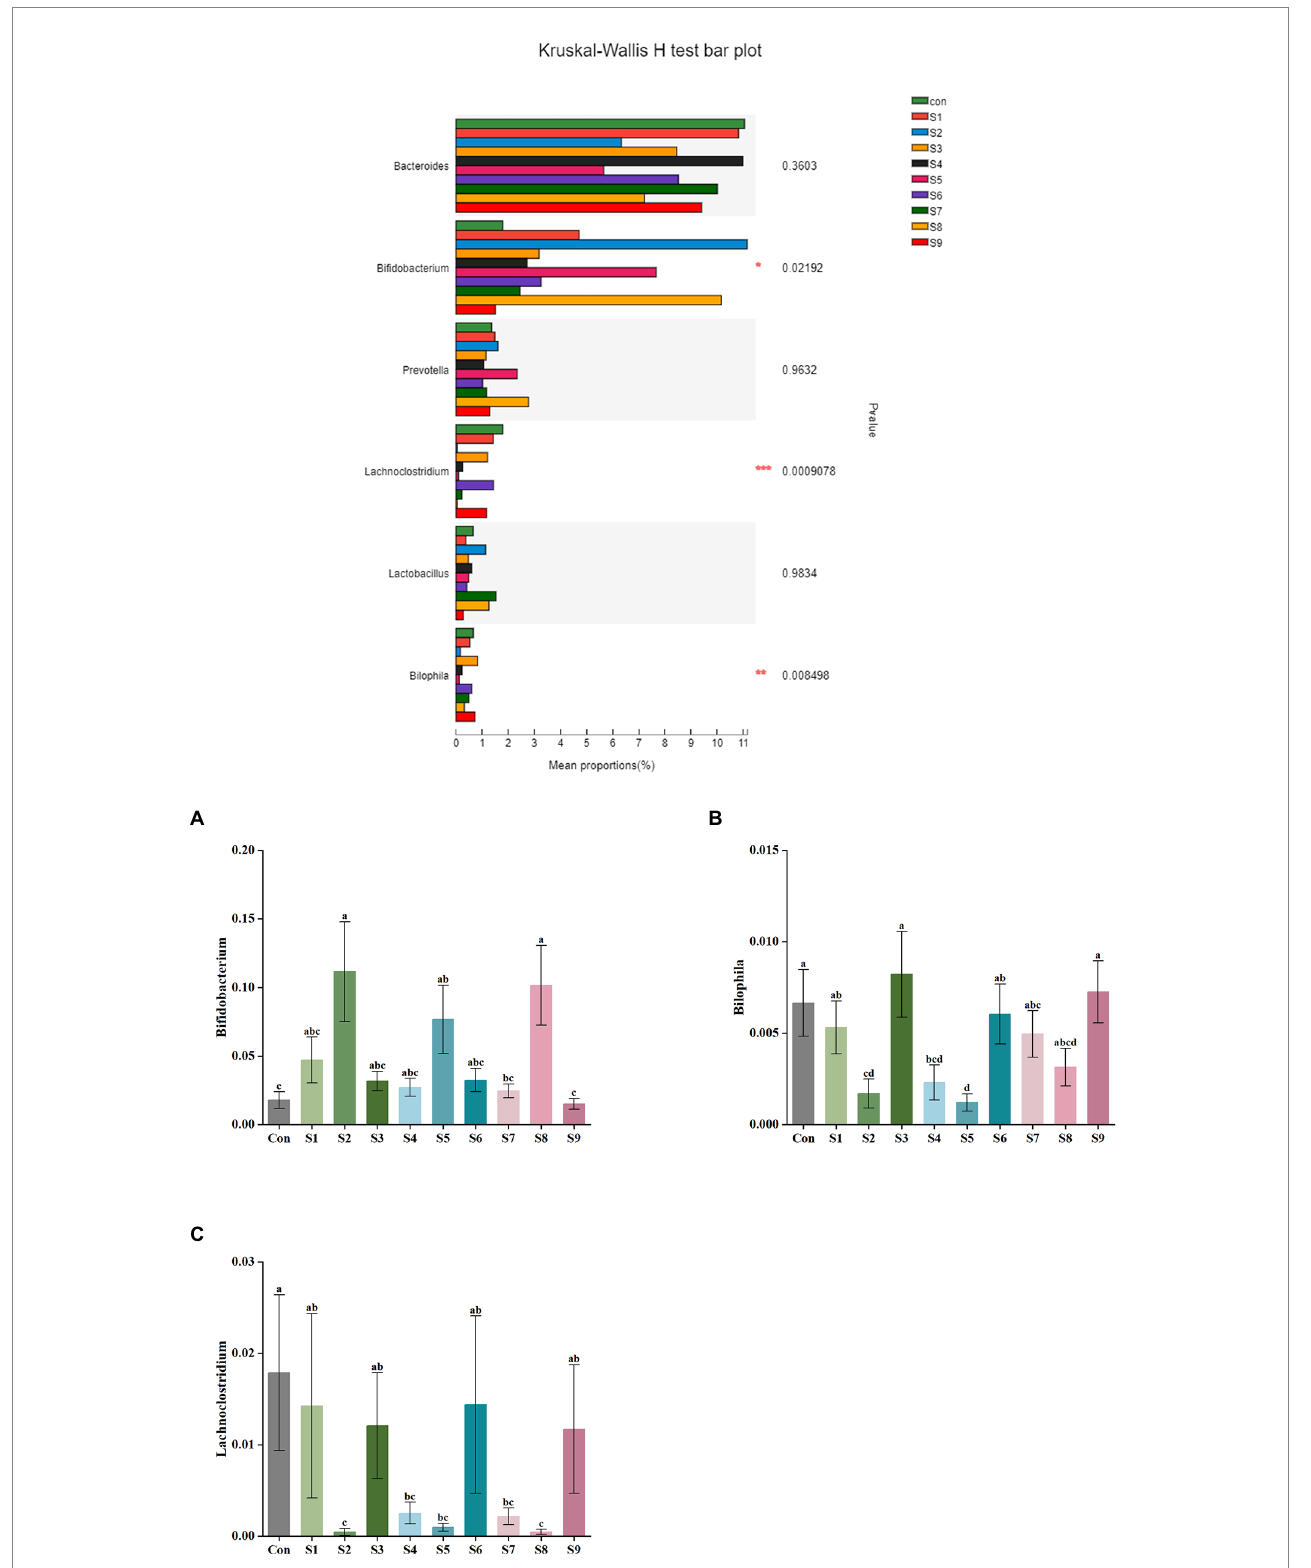
FIGURE 5 Comparison of fecal microbiota under different substrate conditions at the genus level. Relative abundance of Bifidobacterium (A) , Bilophila (B) , and Lachnoclostridium (C) in fecal microbiota after fermentation. Data are means ± SEM (10 independent experiments). Different lowercase letters indicate significant differences ( p < 0.05). * 0.01 < p ≤ 0.05, ** 0.001 < p ≤ 0.01, *** p ≤